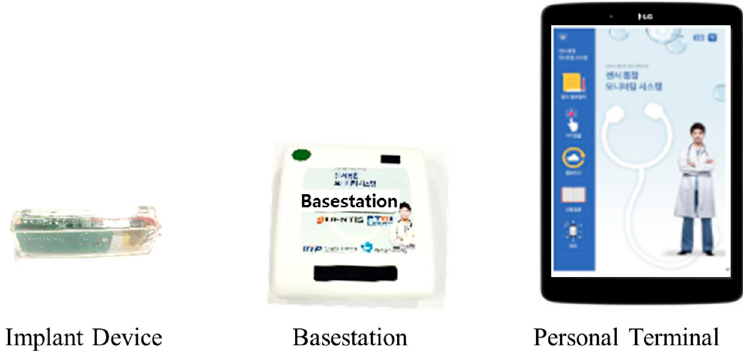
Figure 2. Developed prototype modules of the ECG monitoring system.